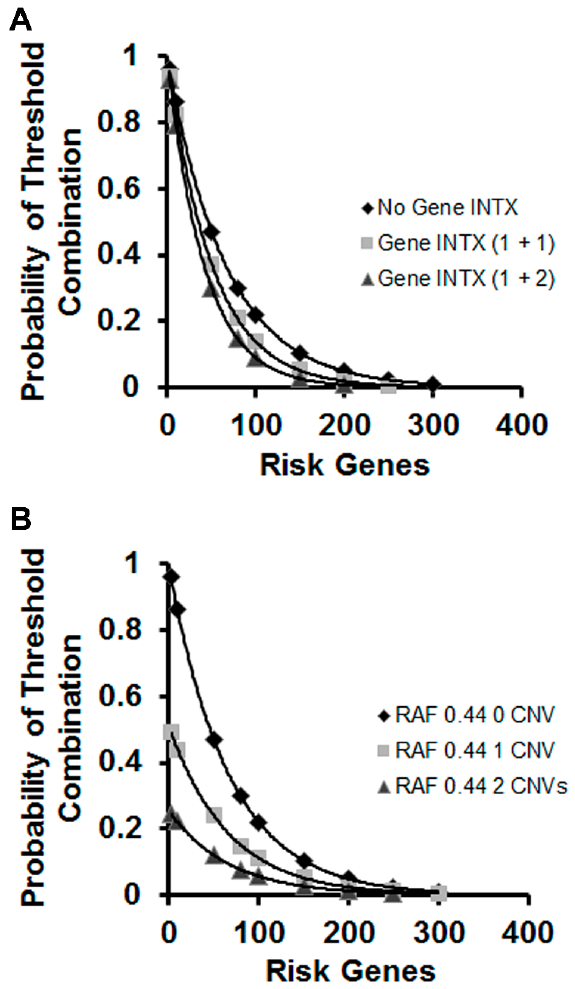
Figure 5. Estimation of risk ‐ gene threshold with inclusion of gene–gene interactions and CNVs. ( A ) Data are plotted for the number of risk genes required to reach the 0.01 probability of threshold combination when gene–gene interactions are included in the calculation. For this model, the VAO is 0.965 and the FLO 0.985 with RAF is set at 0.44. Of the total risk genes, 30% are modeled as interacting with 1 (1 + 1) or 2 (1 + 2) other genes, which require substitution of either 0.97 (0.985 2 ) or 0.956 (0.985 3 ) into Equation (2) for genes with 1 or 2 partners, respectively. For comparison, calculations with no gene interactions (INTX) are also shown. ( B ) With the same settings as (A), the model includes 0, 1 or 2 CNVs, which are represented with FLOs of 0.5.